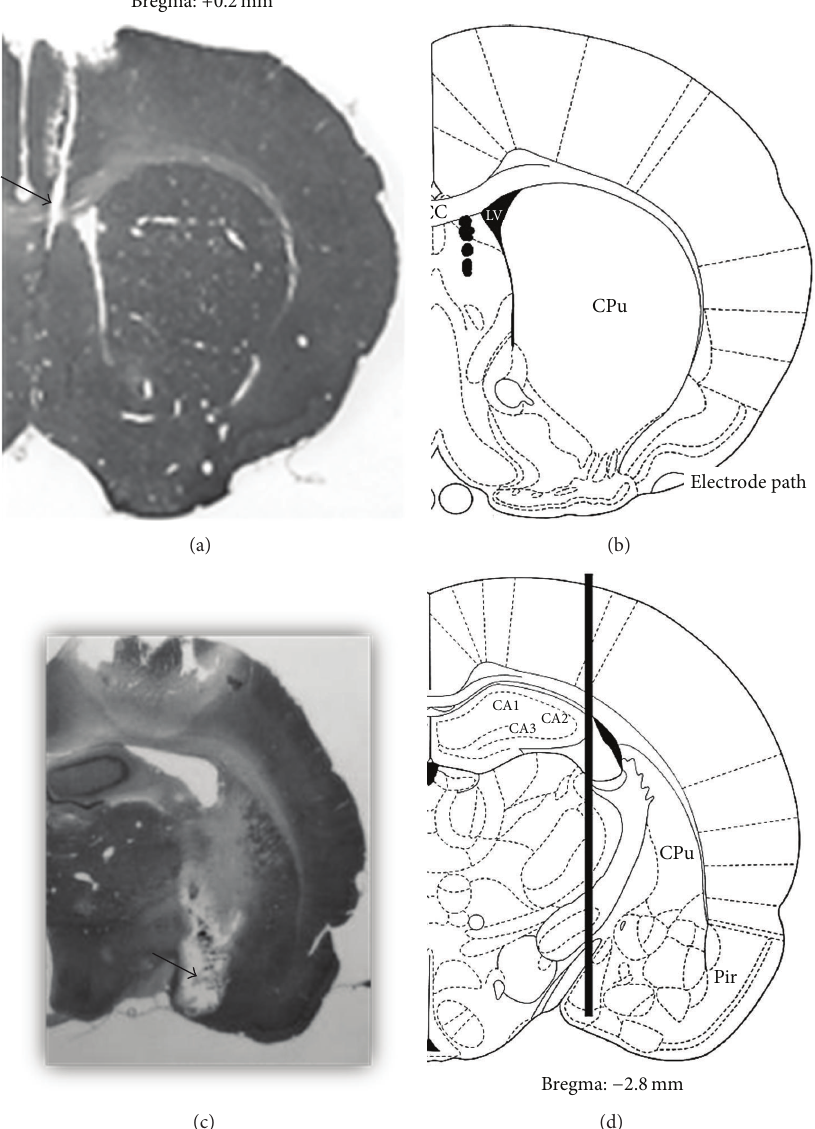
Figure 1: Location of electrodes. (a) Coronal section of the brain (Nissl technique) that shows the recording electrode tips in the dorsal aspect of the lateral septal nucleus (arrow). (b) Representative schematic of a coronal section (+0.2mm) from a rat that illustrates the marks left by the recording electrode. (c) Coronal section (Nissl technique) that shows the marks left by the stimulation electrode in the medial amygdala (arrow). (d) Representative schematic of a coronal section ( − 2.8mm) from a rat that illustrates the marks left by the stimulation electrode. CPu: striatum; LV: lateral ventricle; C: corpus callosum; Pir: piriform